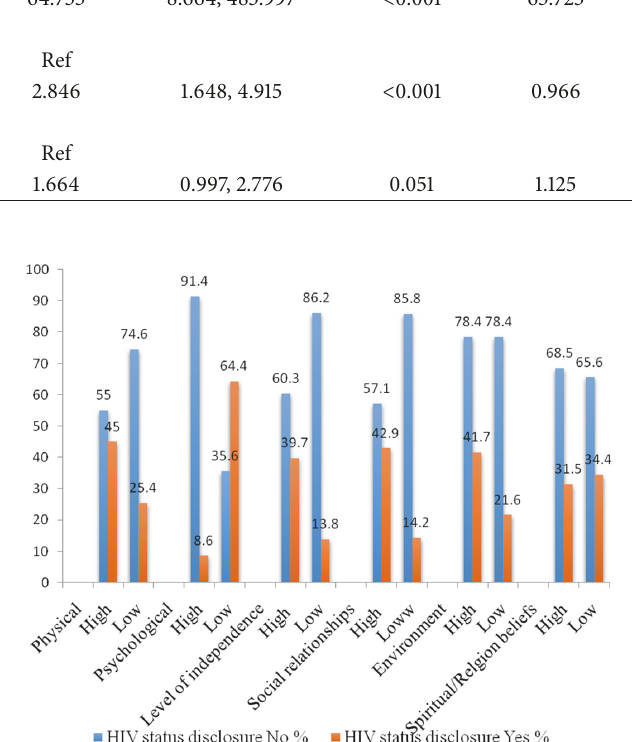
Figure 2: Description of quality of life by domains in relation to HIV status disclosure to children 6-17 years living with HIV/AIDS.